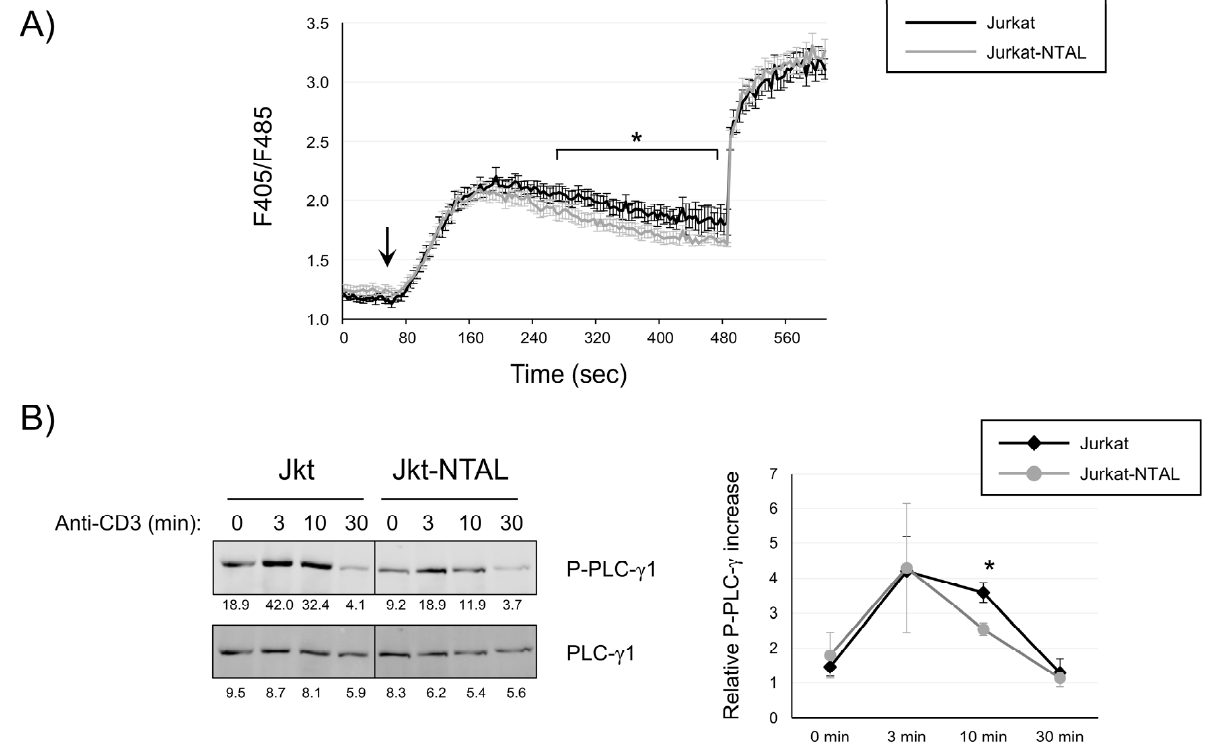
Figure 2. NTAL expression has a negative effect on calcium influx generation and PLC- γ 1 phosphorylation. ( A ) Untransduced Jurkat cells or Jurkat cells expressing NTAL were loaded with Indo-1AM and stimulated with OKT3 mAb (1 µ g/mL) at the indicated time (arrow). The intracellular Ca 2+ concentration was determined at 37 ◦ C through the change in Indo-1AM fluorescence. The mean of 12 independent experiments is shown. Bars represent the standard error. Asterisks indicate where statistical significance was less than 0.05. ( B ) Jurkat and Jurkat-NTAL cells were stimulated at 37 ◦ C with anti-CD3 antibody for the indicated times, and whole-cell lysates were probed by Western blotting for the activation of PLC- γ 1 by using a mAb-recognizing PLC- γ 1 phosphorylated on tyrosine 783 (upper left panel). Stripped membranes were blotted with anti-PLC- γ 1 mAb to show equal protein expression (lower left panel). Densitometric quantification of four independent experiments is shown in the diagram on the right, representing mean fold increase in PLC- γ 1 phosphorylation for Jurkat (black line) or Jurkat-NTAL cells (gray line). The asterisk represents statistical significance ( p < 0.05) using a two-tailed t -test.